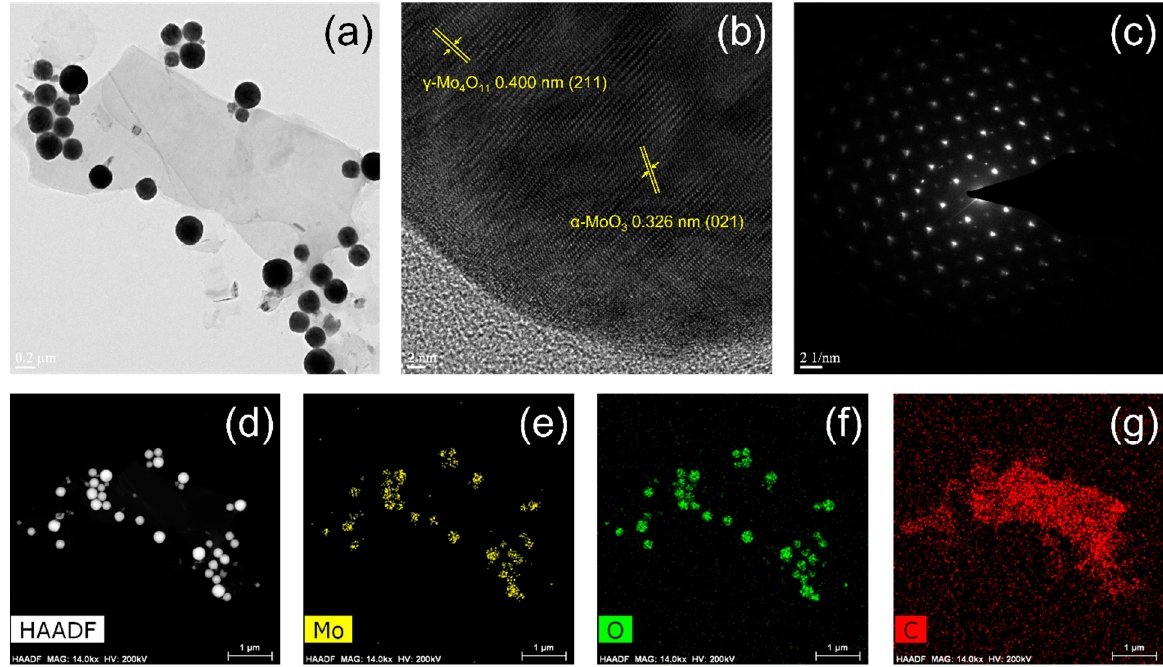
Figure 9. ( a ) Low-magnification and ( b ) high-resolution TEM images, ( c ) SAED pattern, ( d ) HAADF STEM image, and EDS mapping images of ( e ) Mo, ( f ) O, and ( g ) C, acquired for the molybdenum oxide NPs prepared by the CVT method using 1:1 (mol/mol) mixed precursor of MoO 3 and activated carbon. The NPs were harvested from the CFP substrates for the characterization.